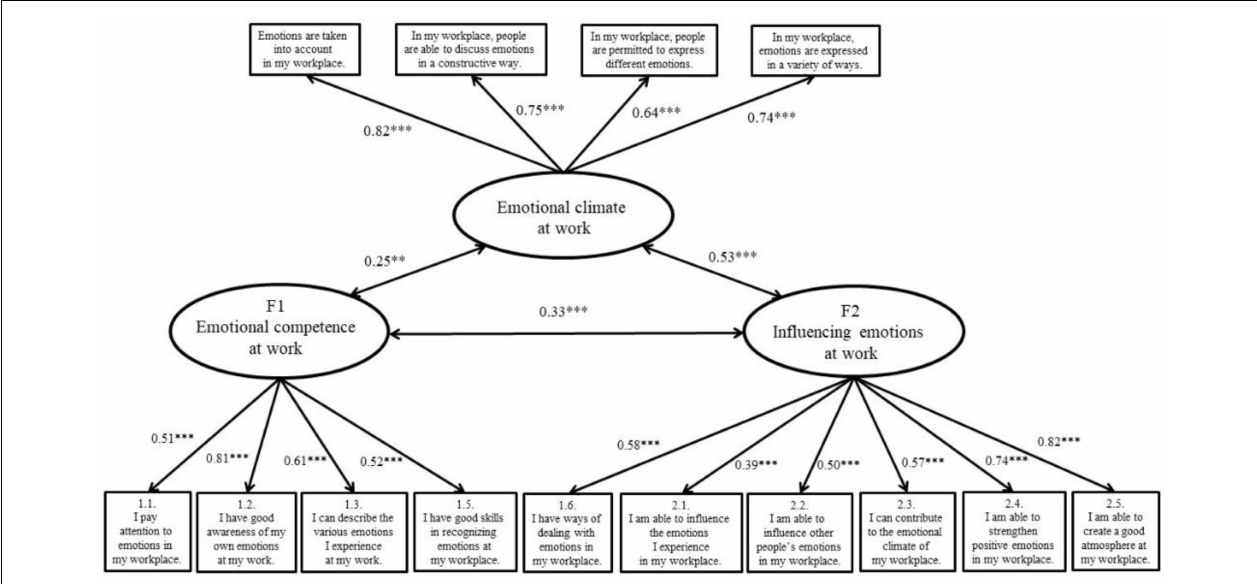
FIGURE 3 | Dimensions of emotional agency in relation to Emotional climate at work ( N = 240). Standardized estimates are presented ( ∗∗ p < 0.01, ∗∗∗ p < 0.001). The numbers before the Emotional agency items refer to the original item numbers shown in Table 1 . Fit statistics: χ 2 (65) = 104.06, p = 0.00; RMSEA = 0.05 [90% CI = 0.03–0.07], CFI = 0.96, TLI = 0.94; SRMR = 0.05.